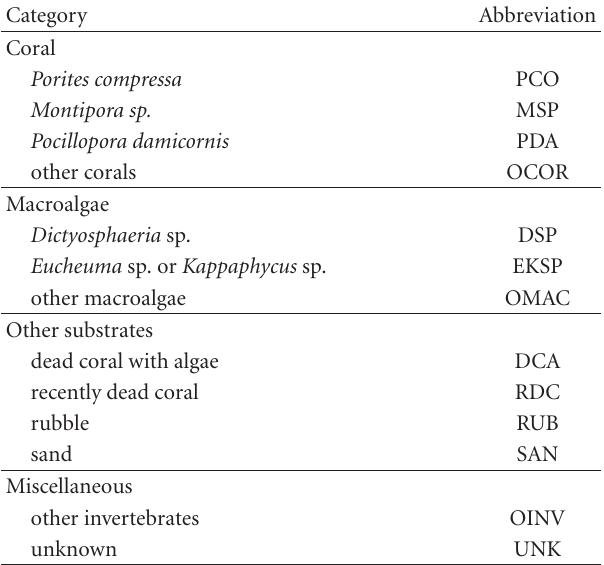
Table 1: Categories and abbreviations used in benthic characteri-